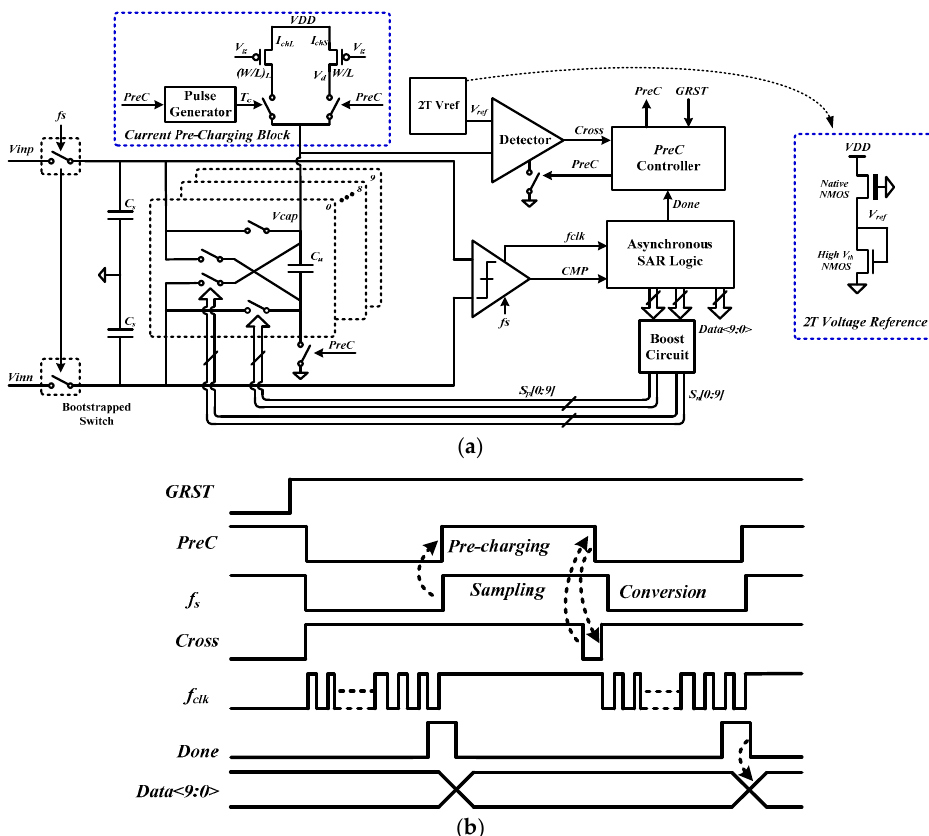
Figure 2. ( a ) Architecture and ( b ) timing diagram of the proposed reference-voltage regulator free SAR ADC with self-timed pre-charging.